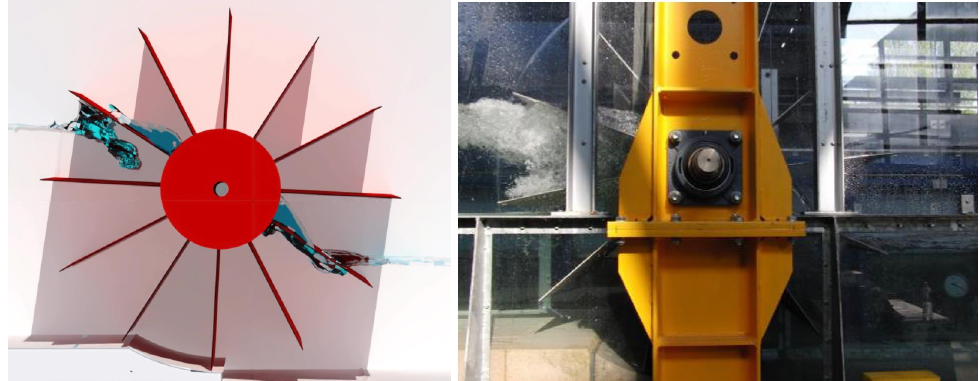
Figure 20. Lateral image of the instantaneous flow of water through the HPM for low discharge. Left image shows an instantant of simulations with caffa3d for Q = 58.9 L/s, while right image shows an instant of experimental tests for Q = 60 L/s [38].